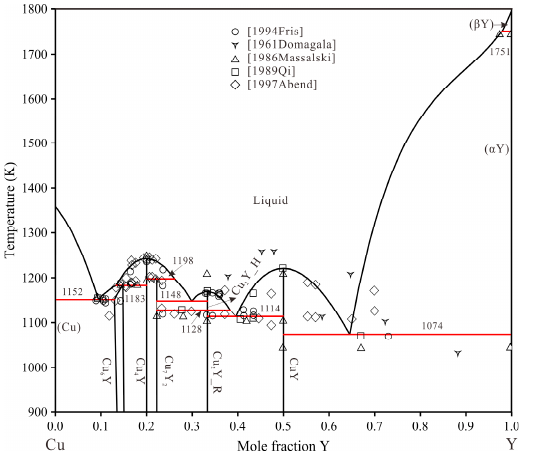
Figure 1. Calculated Cu–Y phase diagram using the parameter from Fries et al. [20] and this work.